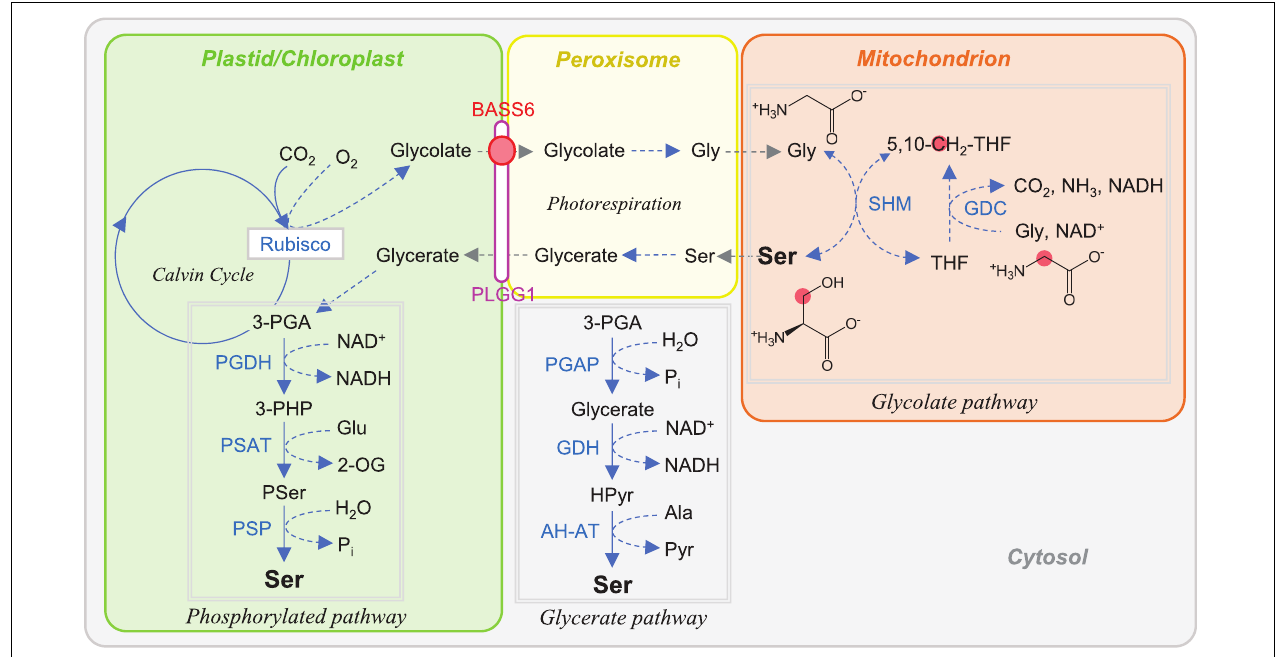
FIGURE 5 | Ser biosynthesis in plant. Carbon atoms of C 1 unit are shown as red circles. Abbreviations are listed in Table 1